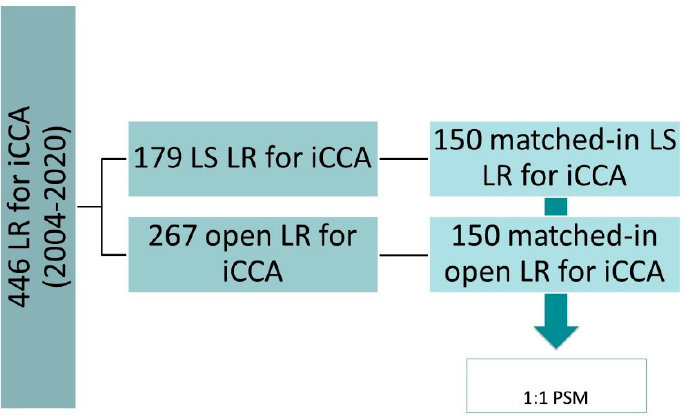
Figure 1. Study design. Abbreviations: iCCA, intrahepatic cholangiocarcinoma; LS, laparoscopic surgery; LR, liver resection; PSM, propensity score matching.